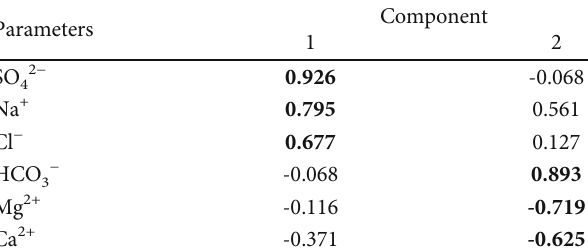
Table 3: Rotated component score